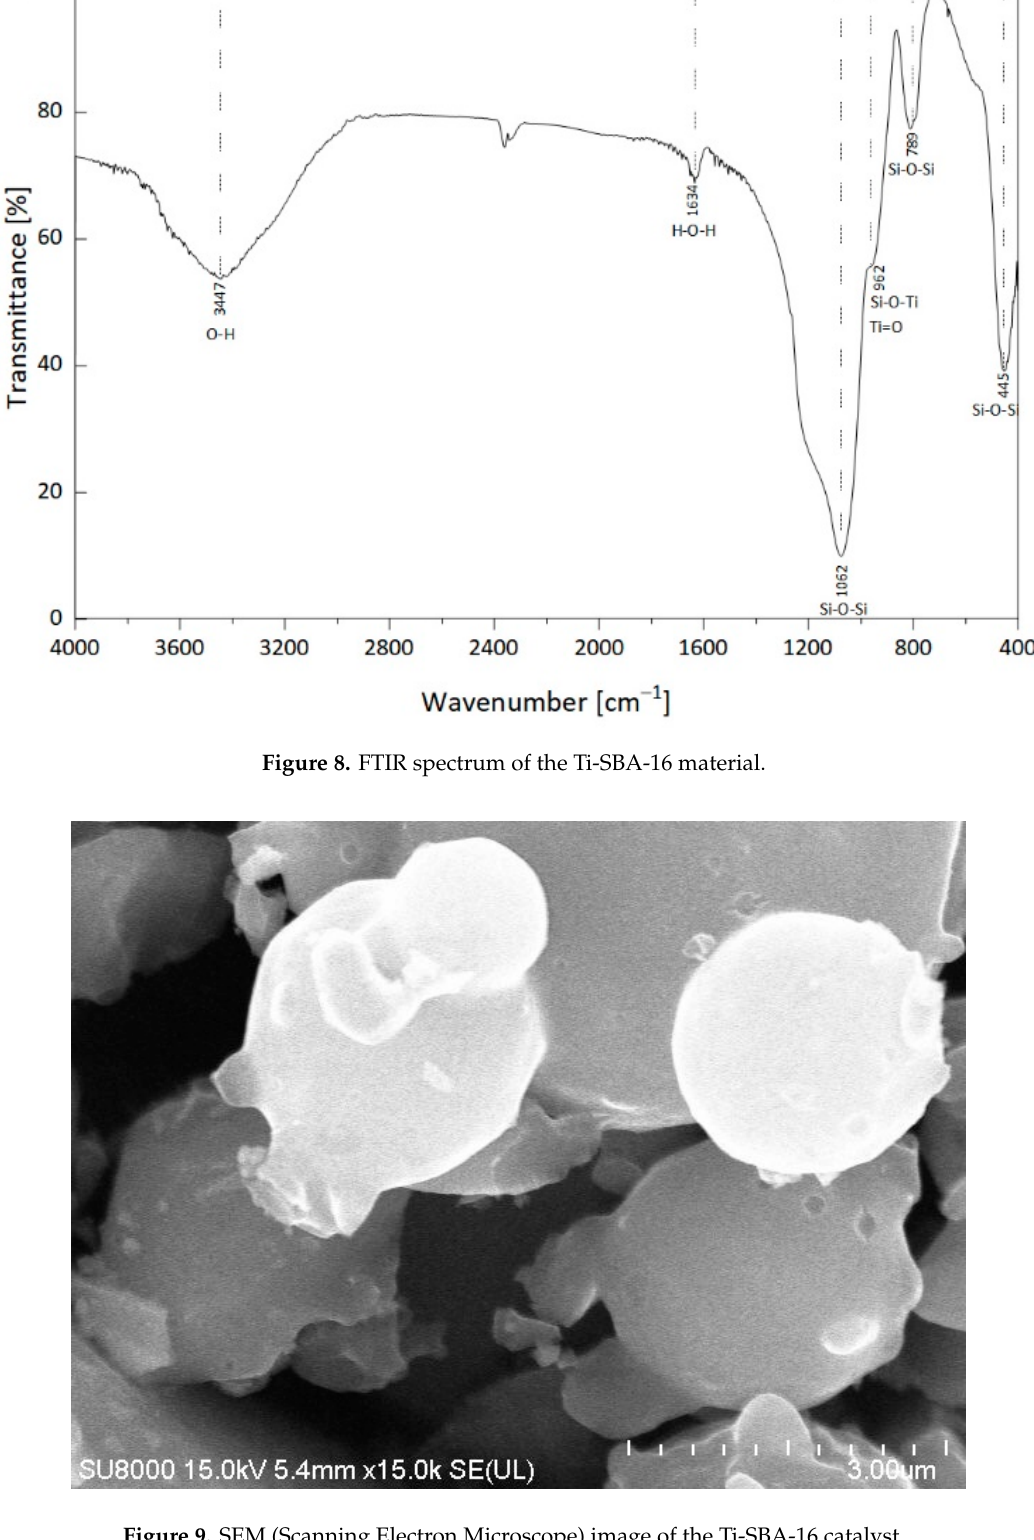
Figure 9. SEM (Scanning Electron Microscope) image of the Ti-SBA-16 catalyst.